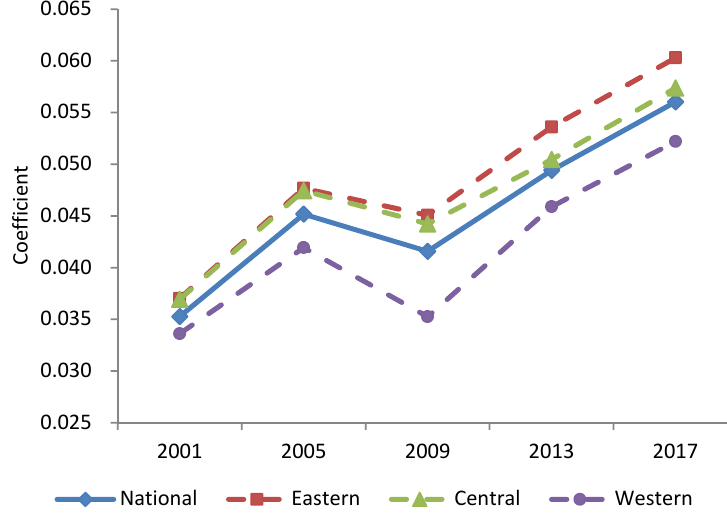
Figure 5. The impact of hydropower on economic growth in various regions.